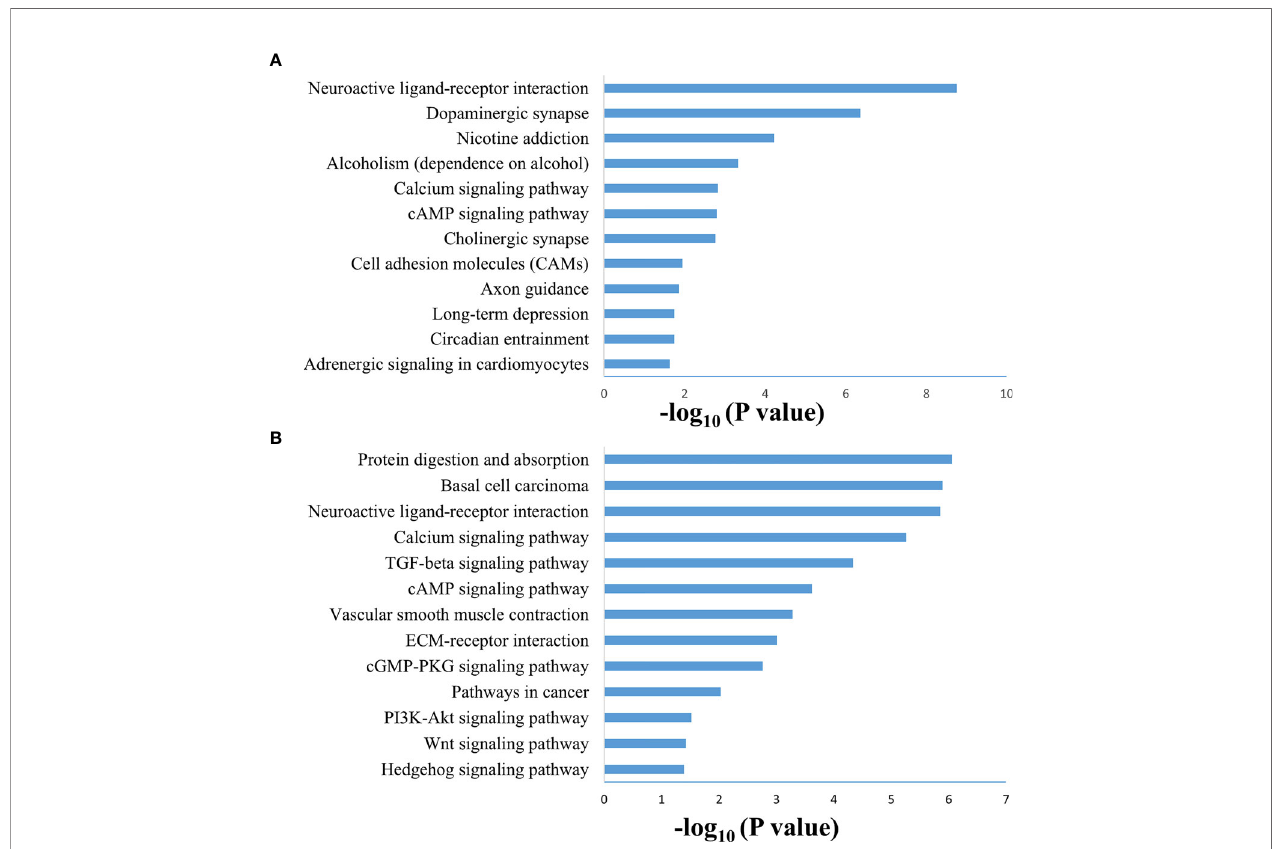
FIGURE 4 | Enriched biological pathways found through the analysis of overexpression of genes individual PCC subtypes. (A) KEGG pathway through the gene overexpression pro fi le analysis in subtype (I) (B) KEGG pathway through the gene overexpression pro fi le analysis subtype